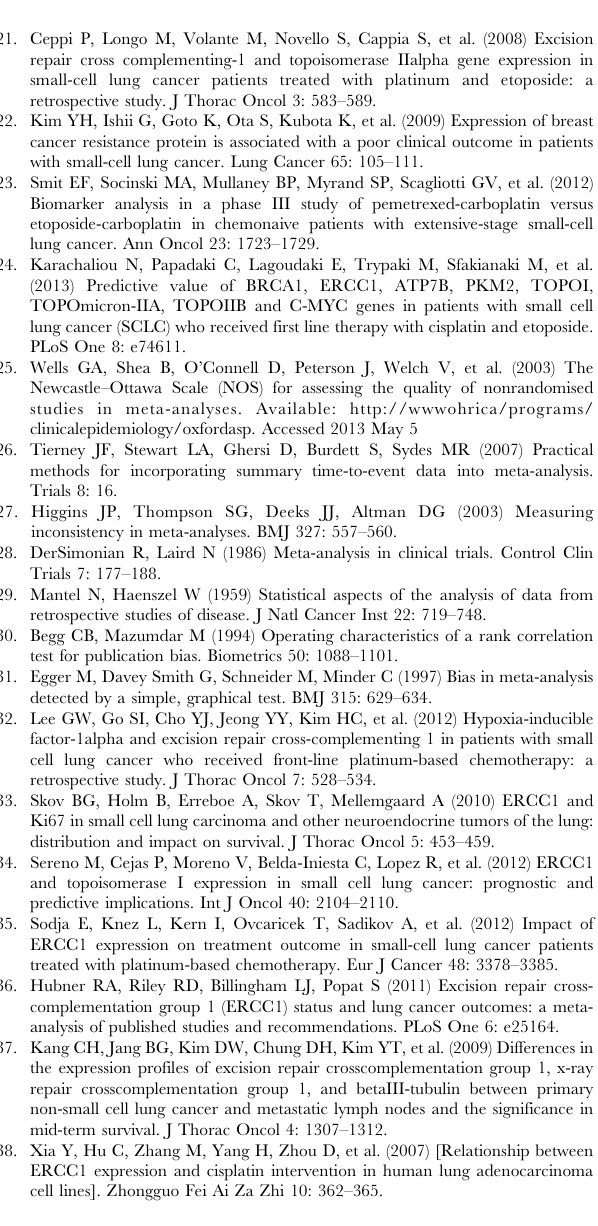
Figure S1 PRISMA flow diagram.